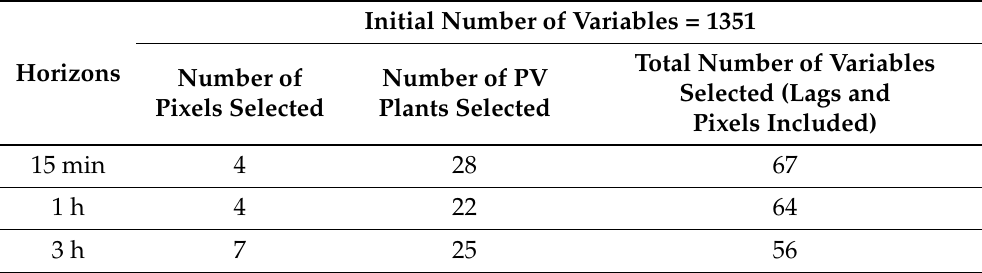
Table 1. Number of pixels and PV plants selected by horizon for a power plant of interest.